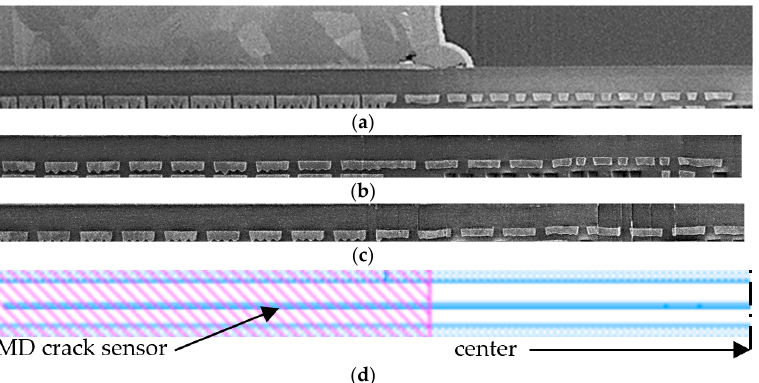
Figure 20. Cross-section along TTML lines: ( a ) unstressed sample; ( b ) sample cycled in 100%AA configuration; ( c ) sample cycled in 90%AA configuration; ( d ) layout.